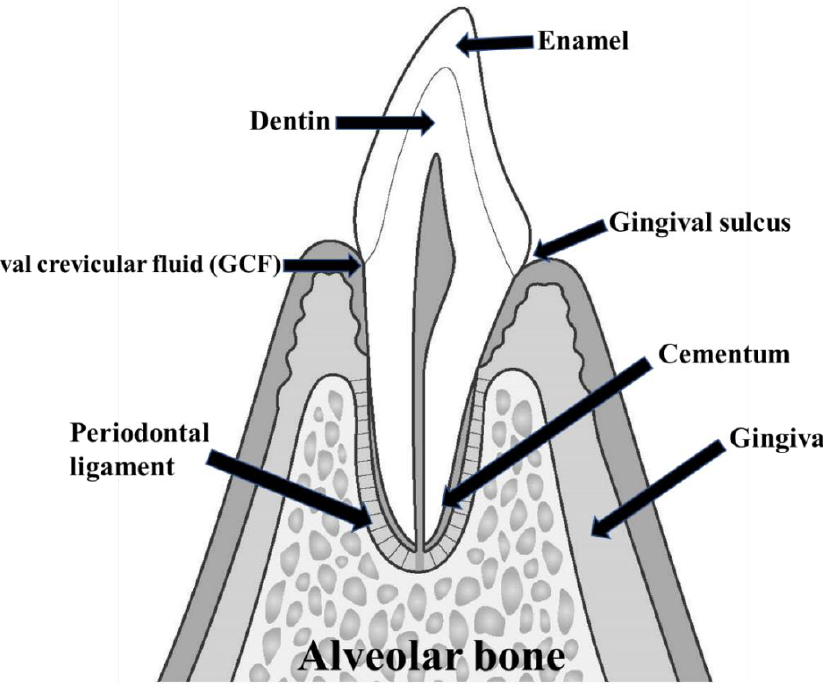
Figure 1. Periodontal tissue and other important factors. Periodontal tissue refers to the tissue that surrounds the teeth and supports their function. Periodontal tissue comprises cementum, gingiva, alveolar bone, and periodontal ligament. Periodontal disease is a general term for diseases that develop in periodontal supporting tissue. GCF, which is the fluid that exudes into the gingival sulcus and periodontal pockets, is thought to reflect the pathology of periodontal disease.